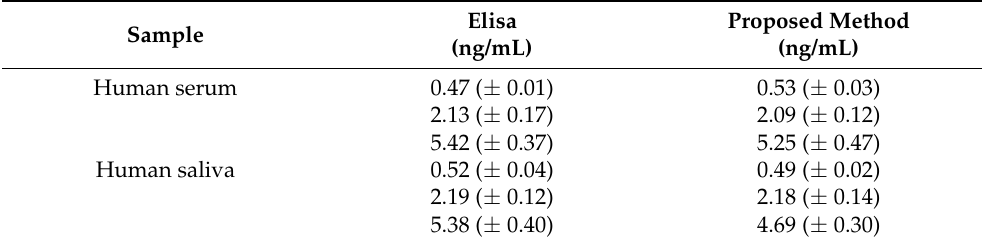
Table 2. Comparison of the ELISA method for detection of human serum and saliva